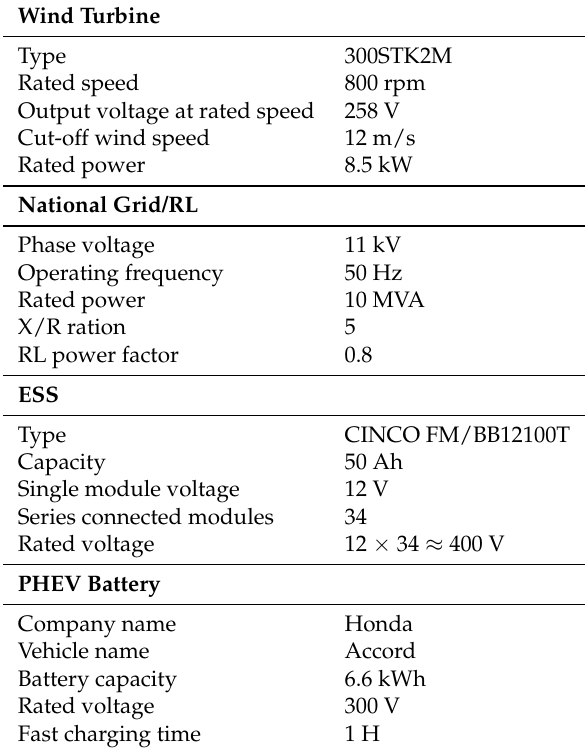
Table 3. Technical data of energy